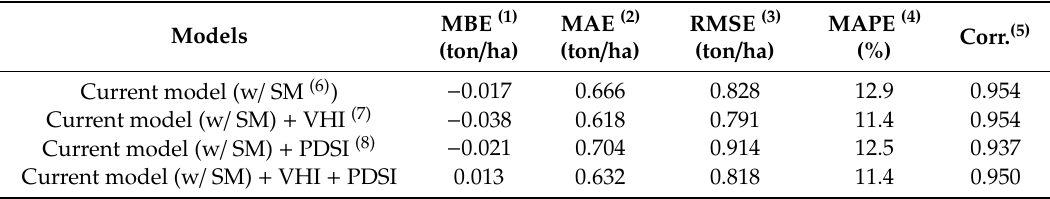
Table 6. Summary of validation statistics according to the addition of drought-related variables for prediction of corn yield in 2012 as a drought